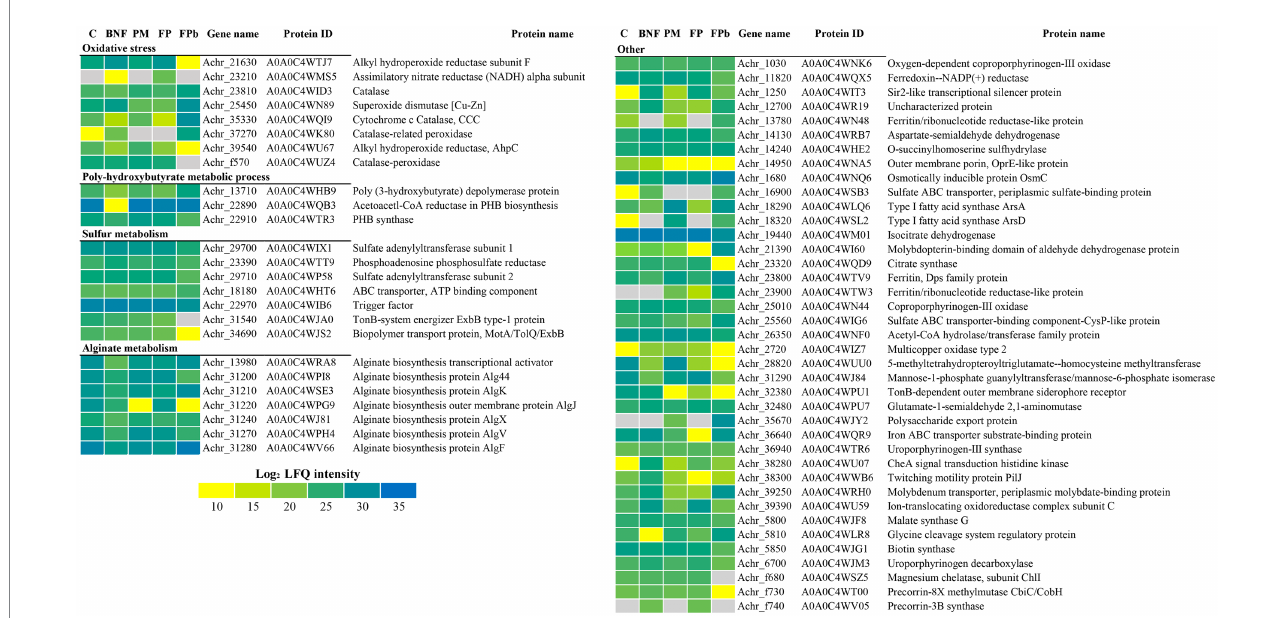
FIGURE 5 Differential expression of some proteins related to oxidative stress, metabolism of poly-hydroxybutyrate, sulfur, alginate and other processes. Data are shown as heatmap of Log 2 normalized peptide intensity. C, control condition; BNF, biological nitrogen fixation condition; PM, phosphorus mobilization condition; FP, biological nitrogen condition and phosphorous condition (21 h); FPb, biological nitrogen condition and phosphorous condition (72